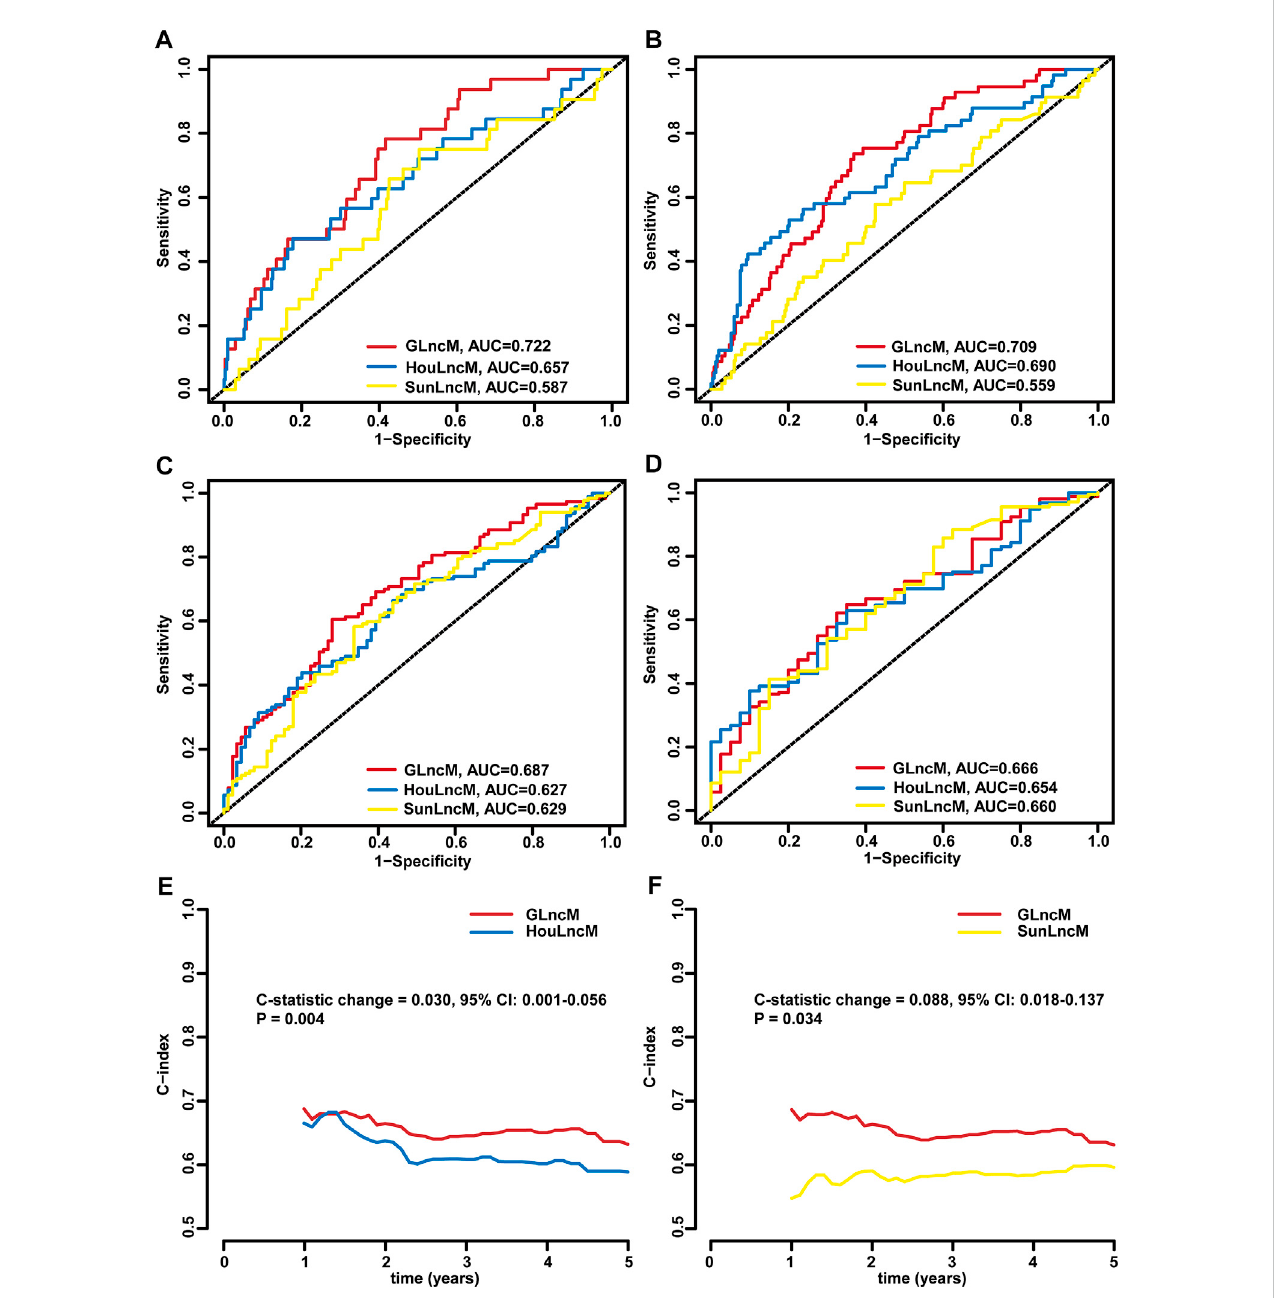
FIGURE 5 Comparison of the performance of GLncM with other models. ROC analysis at 0.5 years (A) , 1 year (B) , 3 years (C) and 5 years (D) of OS for GLncM, HouLncM and SunLncM. The C-statistic was applied to assess prognostic performance for predicting the OS of HCC patients. The change C-statistic change was calculated for GLncM and HouLncM (E) and GLncM and SunLncM (F) in TCGA-LIHC cohort. GLncM: genomic instability-related lncRNA model; HCC: hepatocellular carcinoma; HouLncM: lncRNA-based model from the study by Hou; ROC: receiver operating characteristic; SunLncM: lncRNA-based model from the study by